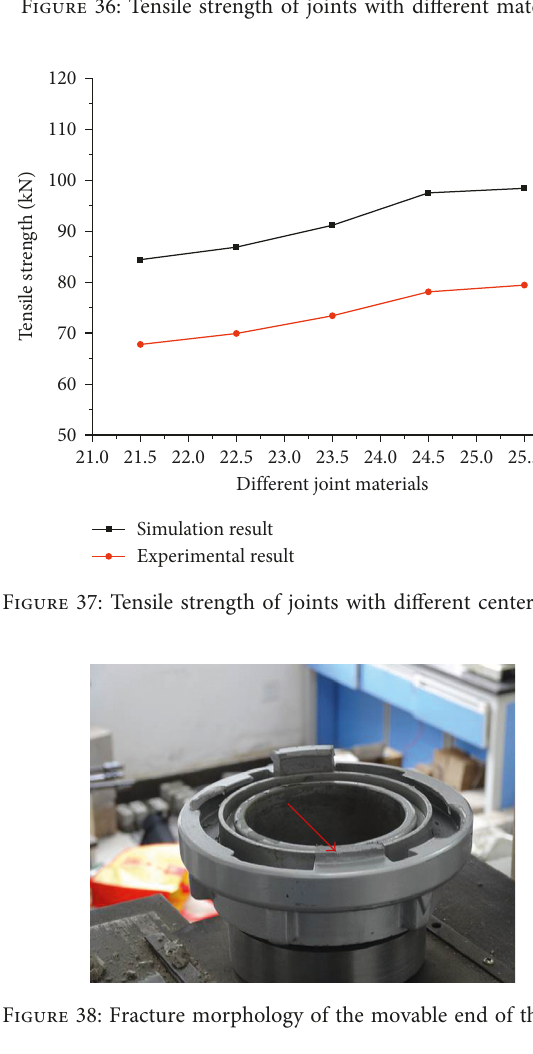
Figure 36: Tensile strength of joints with different materials.